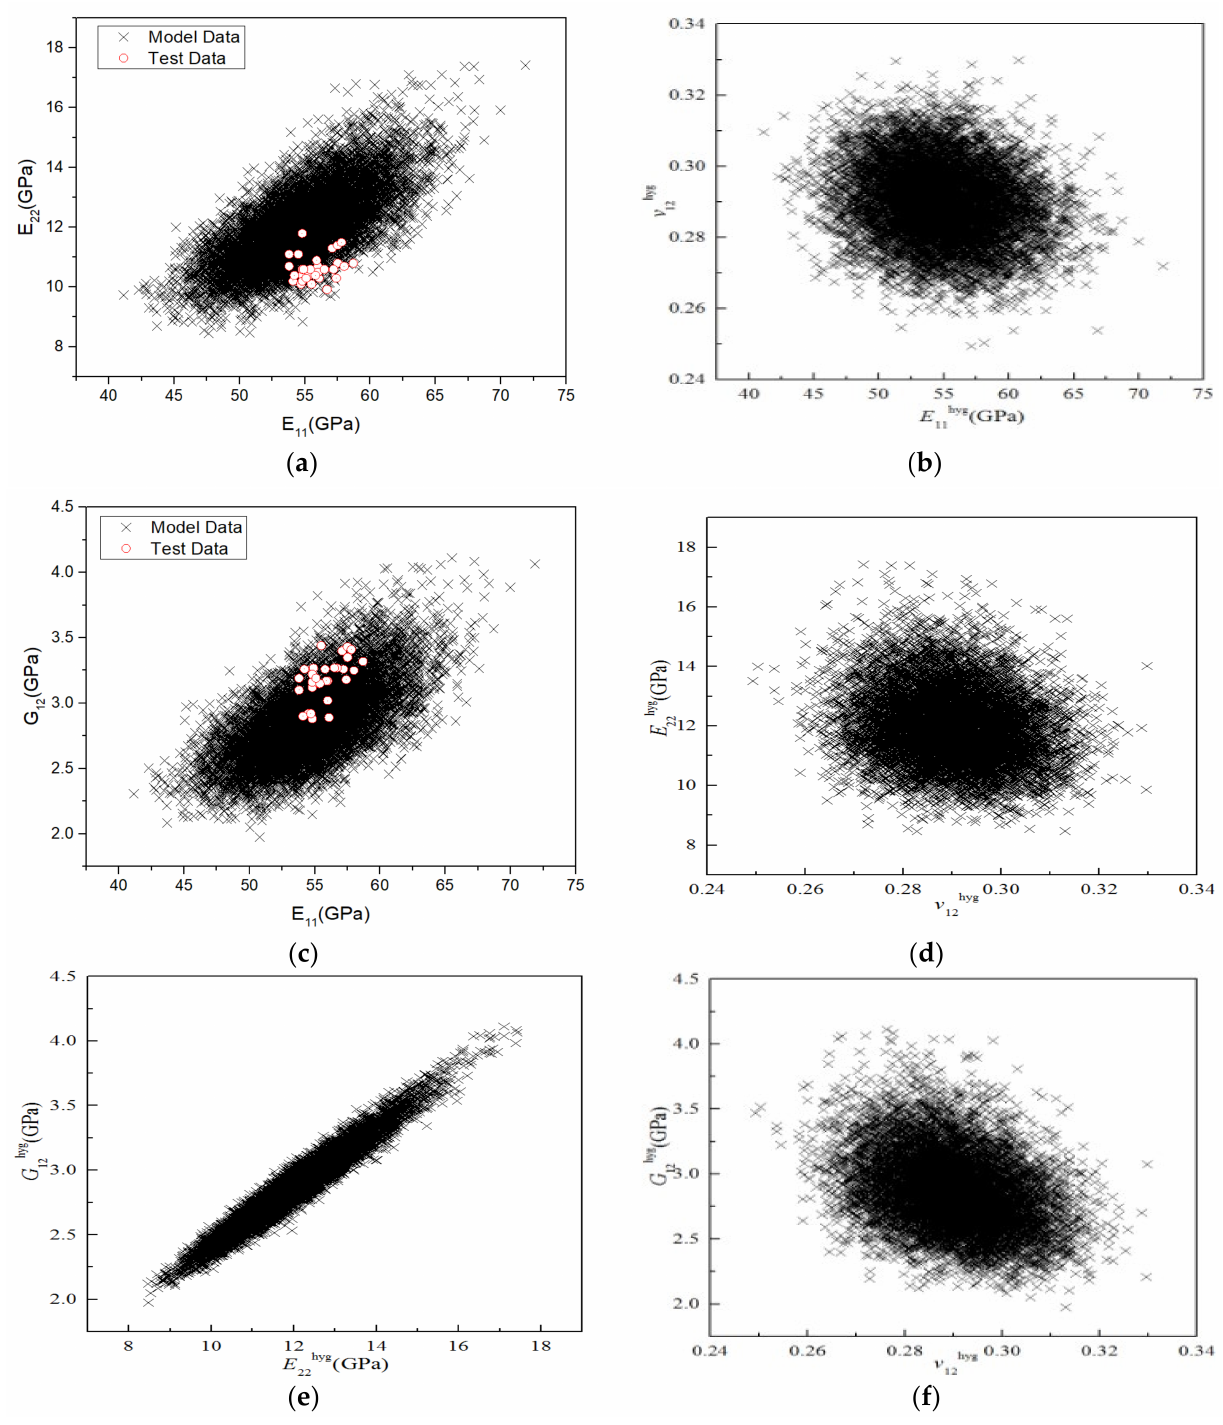
Figure 23. Diagrams of correlation between the stiffness properties of H-GFRPs under the ETW condition. ( a ) E 11 and E 22 , ( b ) E 11 and v 12, ( c ) E 11 and G 12 , ( d ) E 22 and v 12, ( e ) E 22 and G 12 , ( f ) v 12 and G 12